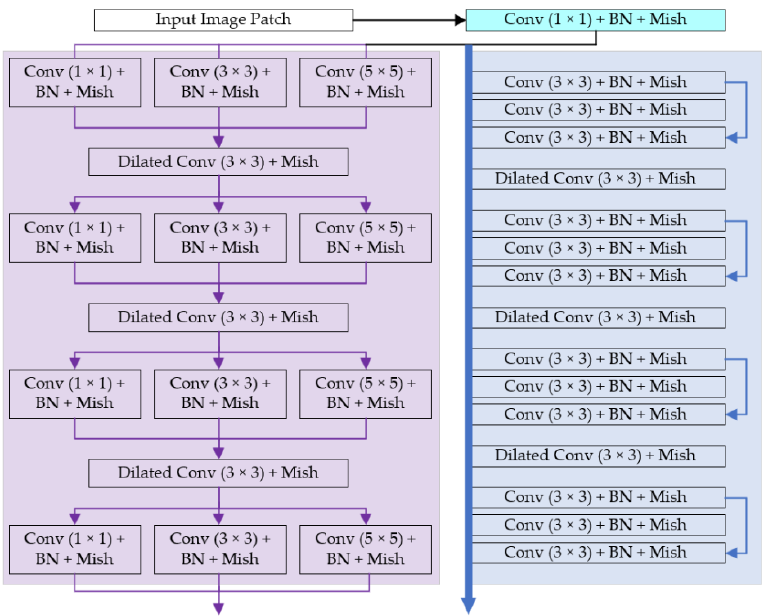
Figure 4. The structure of the MKM feature extractor and the RM feature extractor. The input is a batch of noised image patches sized 50 × 50. The purple part belongs to the MKM, containing 4 Inception-like blocks; the blue part belongs to the RM, containing 4 residual blocks. The activation method of each convolutional layer is Mish, and the filter number of each layer is 32. Except the dilated convolution layers, all convolutional layers are followed by batch normalizations.